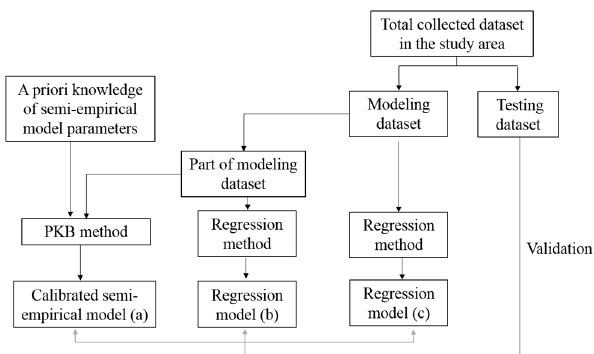
Figure 3. Process to evaluate whether the PKB method integrating a priori knowledge of model parameters can improve the model accuracy with the limited dataset, compared with the regression method. The root mean square error (RMSE) was used to quantify the deviation between two datasets: